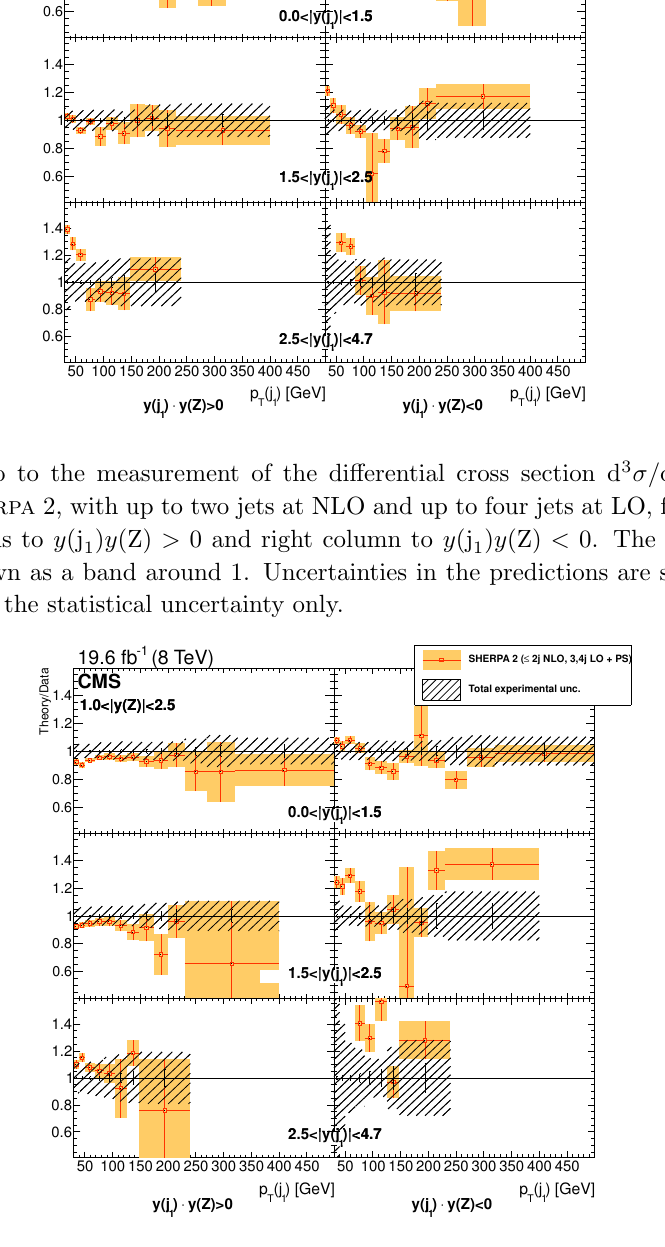
Figure 41 . Ratio to the measurement of the di(cid:11)erential cross section d 3 (cid:27)= d p T (j )d y (j )d y (Z) 1 1 obtained with sherpa 2, with up to two jets at NLO and up to four jets at LO, for j y (Z) j 2 (1 ; 2 : 5). Left column corresponds to y (j ) y (Z) > 0 and right column to y (j ) y (Z) < 0. The total experimental 1 1 uncertainty is shown as a band around 1. Uncertainties in the predictions are shown on the ratio points and include the statistical uncertainty only.